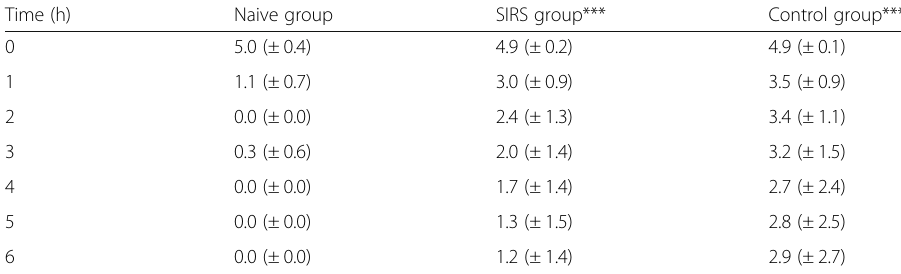
Table 2 Bacterial counts showing blood ex vivo bactericidal capacity Time (h)